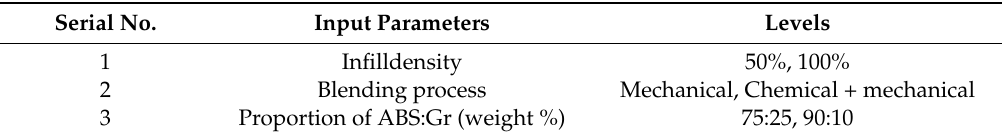
Table 2. Input parameters.